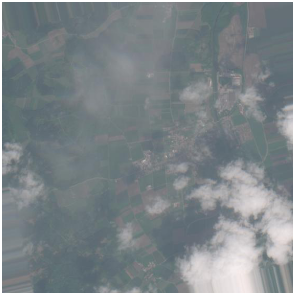
Figure 13. Test area Mch west of Munich, 5 × 5 km 2